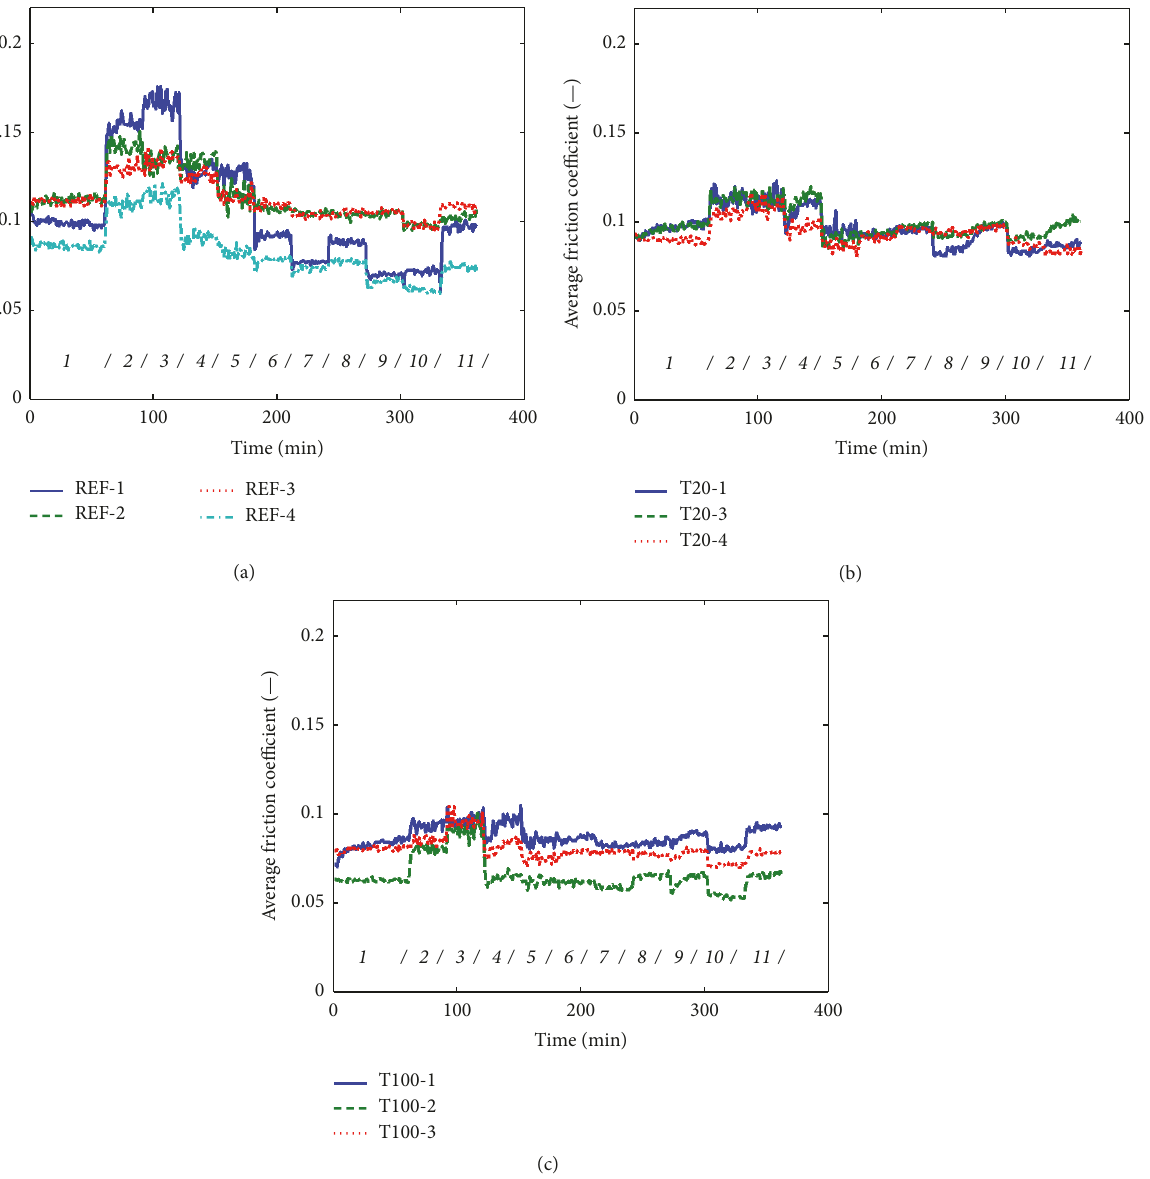
Figure 7: Measured friction coefficient for each experiment. The numbers above the 𝑥 -axis (italics) indicate the duration of each experimental cycle step. (a) REF. (b) T20. (c)